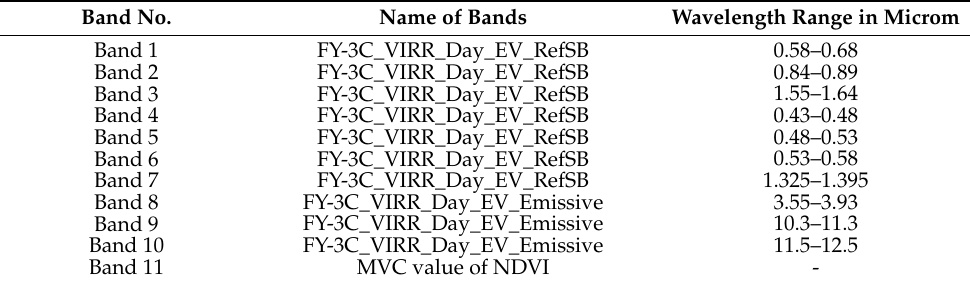
Table 1. List of selected bands of 10-day composite images of FY-3C.